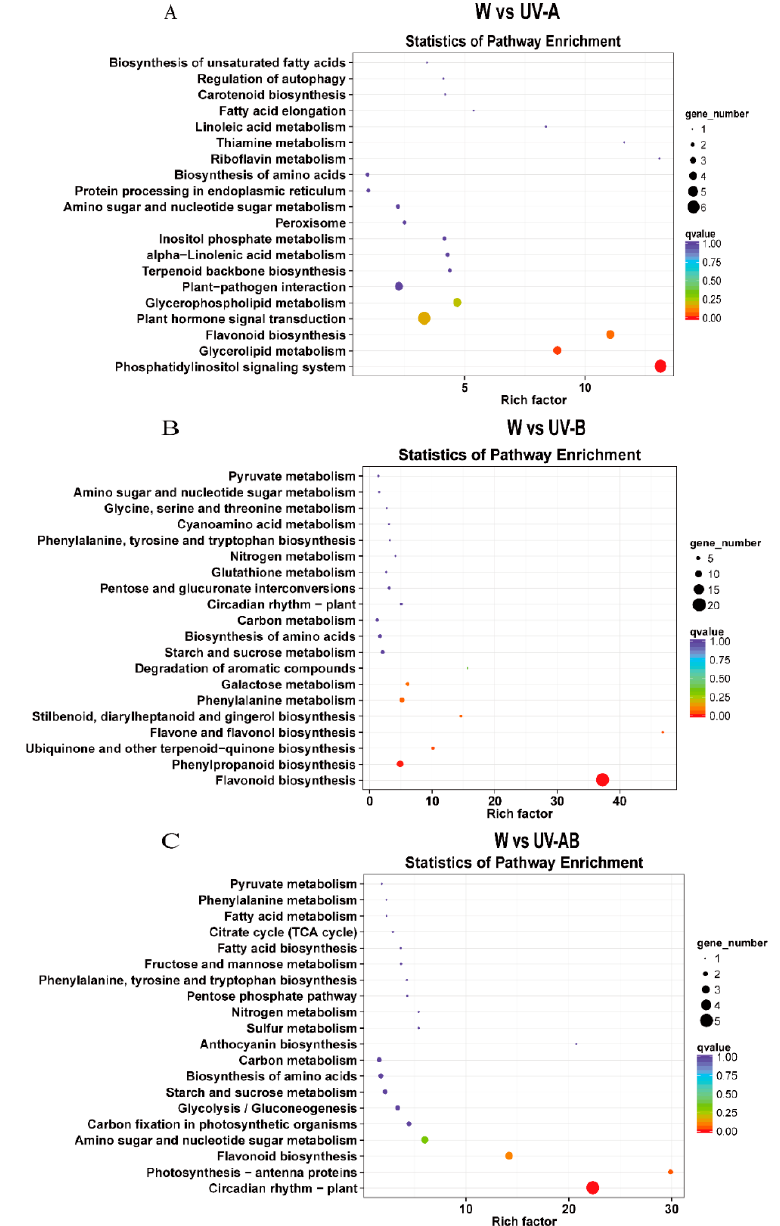
Figure 6. Kyoto Encyclopedia of Genes and Genomes (KEGG) enrichment analysis in pairwise comparisons. ( A ) KEGG enrichment analysis in W vs. UV-A. ( B ) KEGG enrichment analysis in W vs. UV-B. ( C ) KEGG enrichment analysis in W vs. UV-AB.